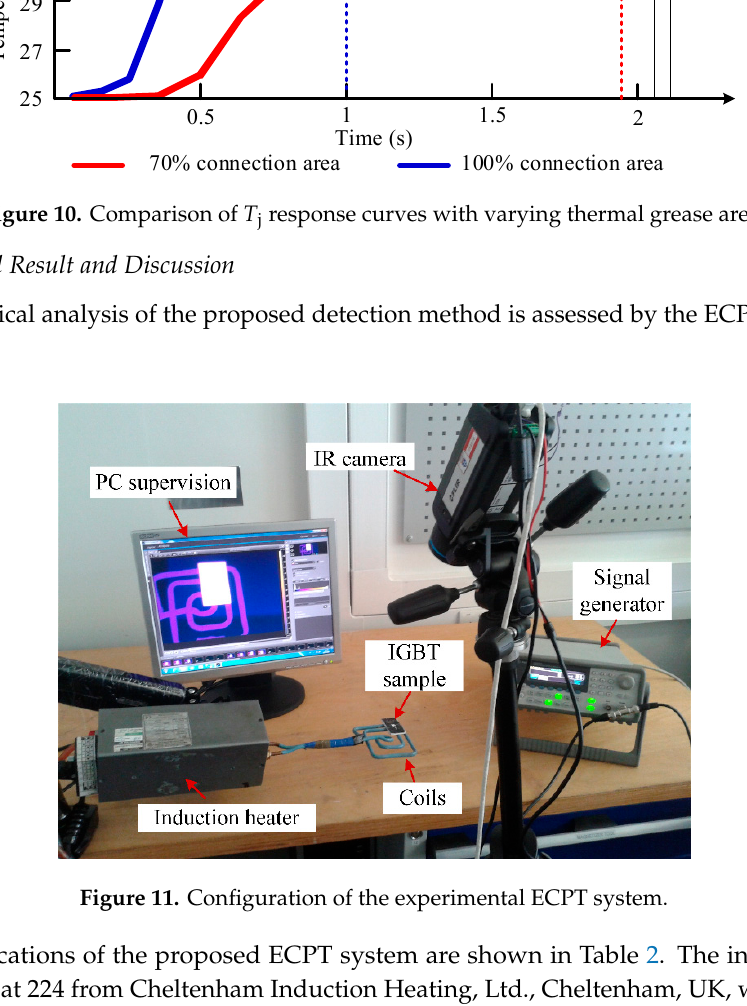
Figure 11. Configuration of the experimental ECPT system.